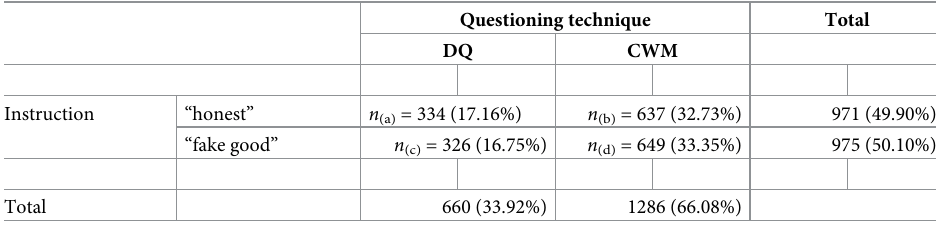
Table 1. Distribution of participants across experimental